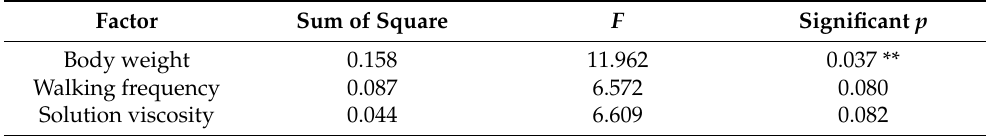
Table 5. Three-factor ANOVA with b as the indicator. Factor Sum of Square F Significant p Body weight 0.158 11.962 0.037 ** Walking frequency 0.087 6.572 0.080 Solution viscosity 0.044 6.609